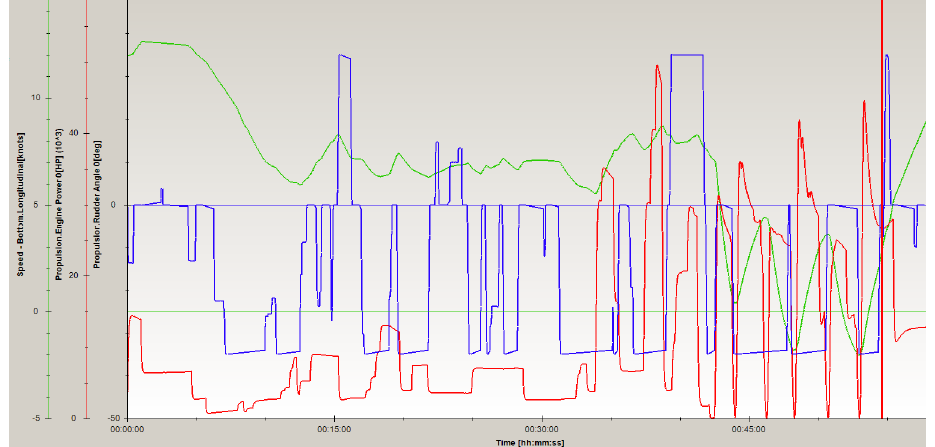
Figure 10. Sailing parameters of PANAMAX type container vessel crossing navigational channel near Korsakobben Island (departure from Stockholm archipelago), where: speed (green line); rudder angle (blue line); engine power (red line) (own elaboration based on [73]) (remark: − 5; − 50 in the figure read as –5; –50).